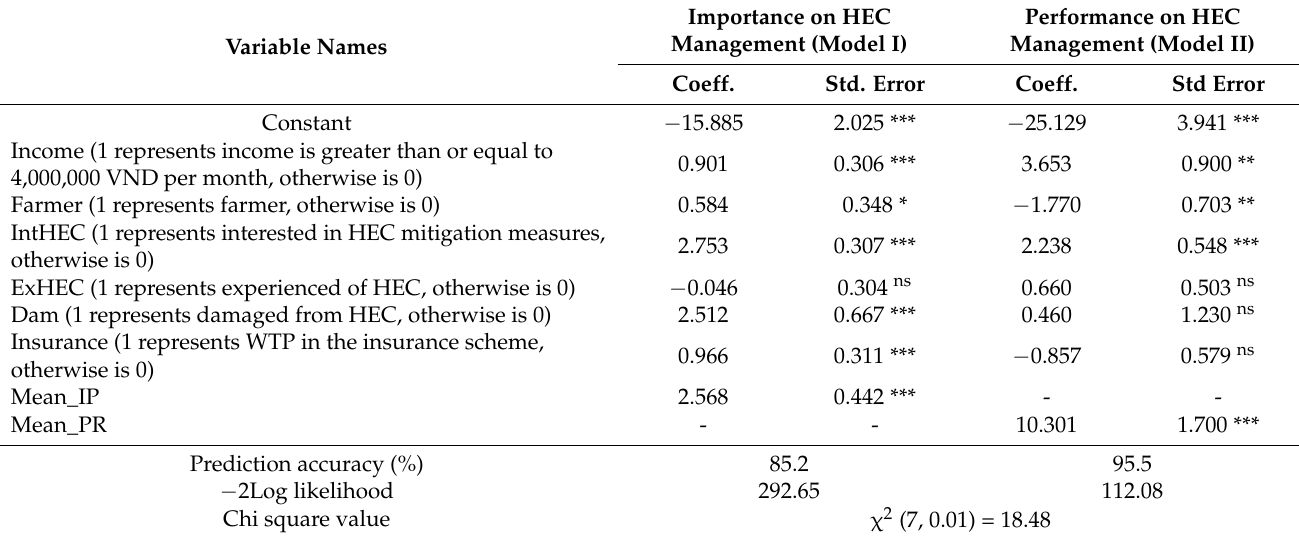
Table 4. Estimation results of locals’ participation behavior towards HEC